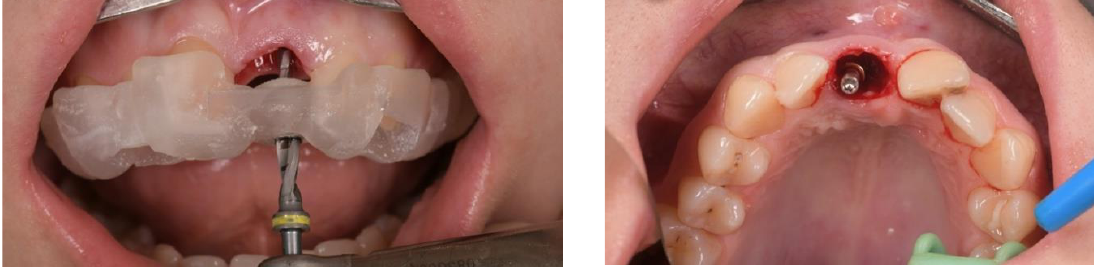
Figure 7. Using the surgical guide for implant surgery.